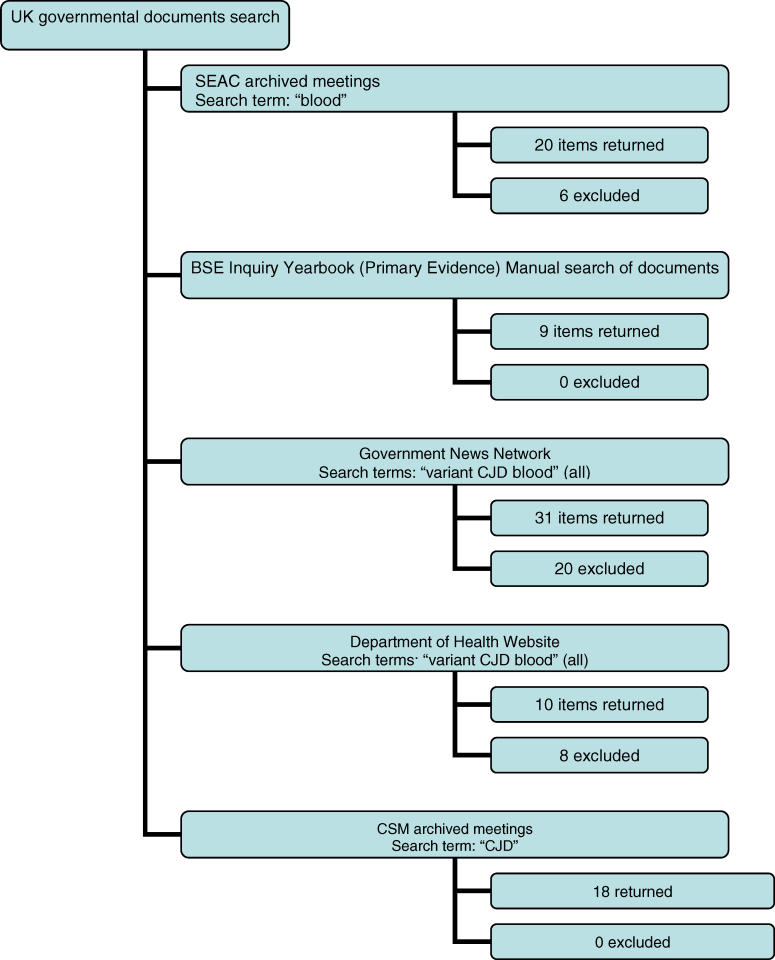
UK Government DocumentsSearches conducted with results returned and excluded at each step.